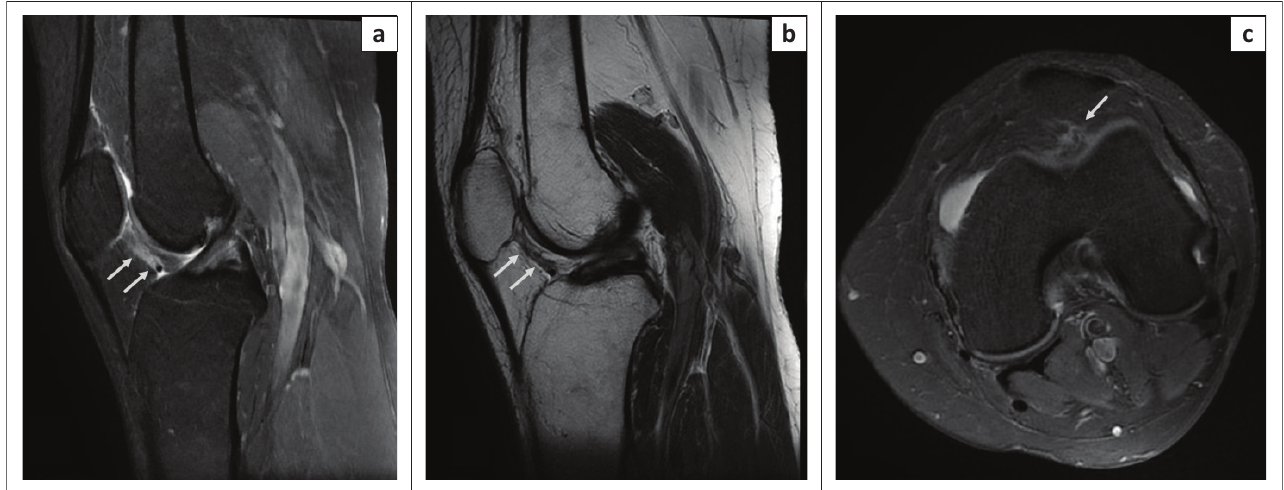
FIG URE 4: Magnetic resonance imaging (MRI) of infrapatellar plica sprain in a 50-year-old female with a history of twisting the knee: oblique sagittal PDFS image (a), T2WI (b) and axial PDFS image (c) indicate hyperintense signal along the entire course of infrapatellar plica (arrow), from the transverse inter-meniscal ligament to the inferior pole of patella, with its margins appearing ragged. Note the signal is less hyperintense than that of the synovial fluid. No other abnormality was noted on the patient’s knee MRI.